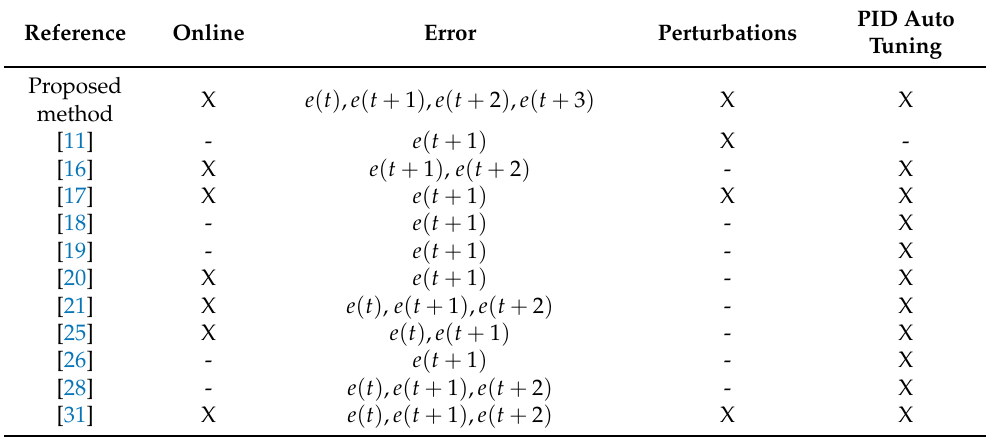
Table 2. Work comparative. The symbol X represents a characteristic considered in the investigation. On the other hand, - represents an unconsidered